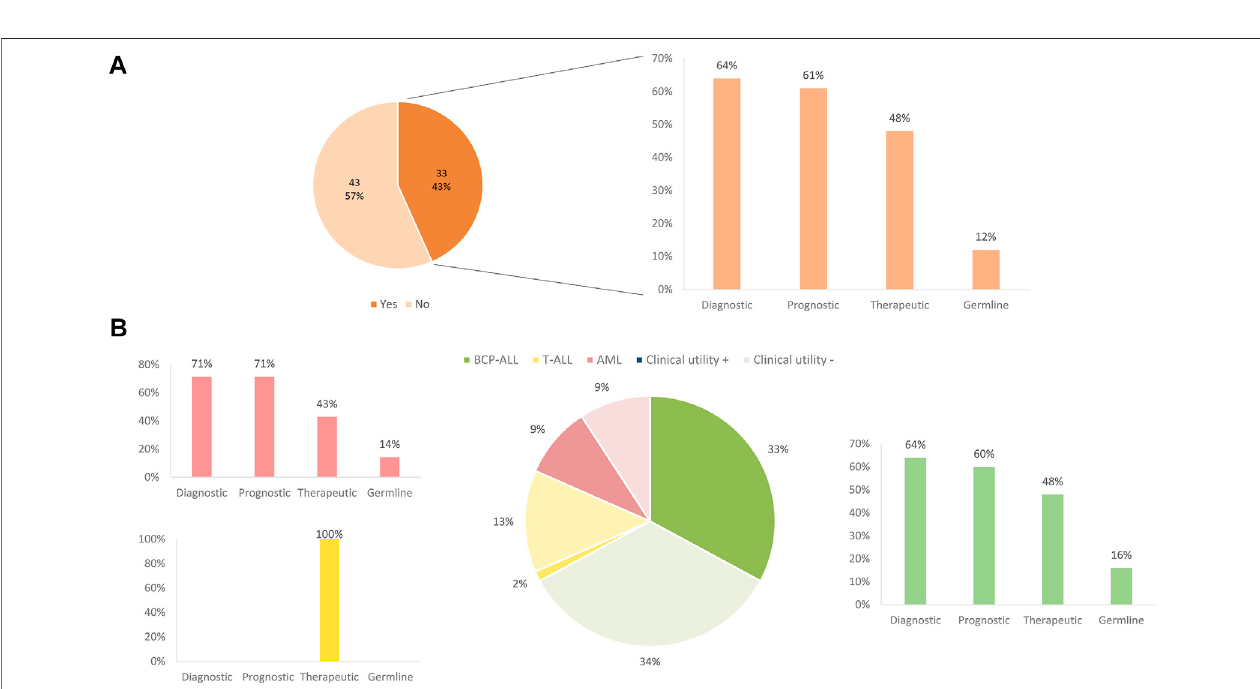
FIGURE6| Clinicalimpactofpanelsequencingbysubtypeofleukemia. (A) Overallclinicalimpact classi fi edbythebene fi tapported. (B) Clinicalimpactandbene fi t category depending on the different subtype of leukemia.